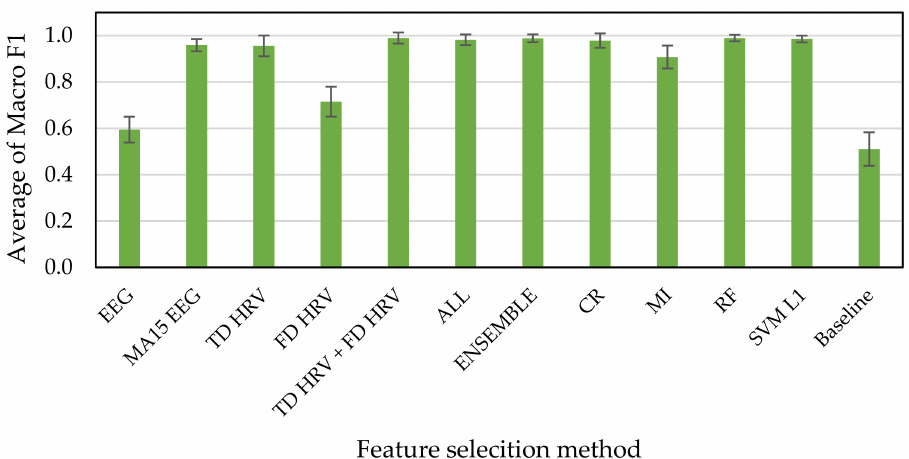
Figure 11. Low Arousal, High Arousal (2 classes) emotion classification accuracies.